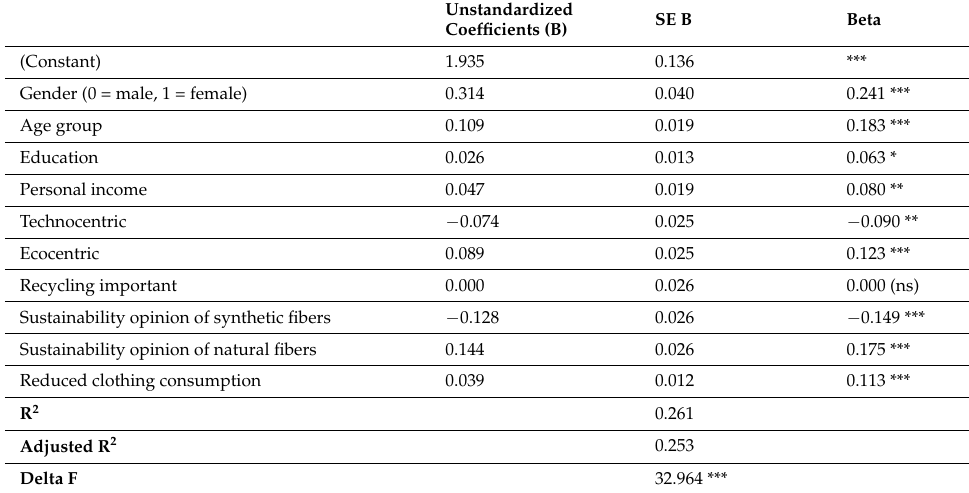
Table 5. Regression model 1 for fiber preference. (SE B = standard error for B. * p < 0.05; ** p < 0.01; *** p < 0.001, ns = not significant, p ≥